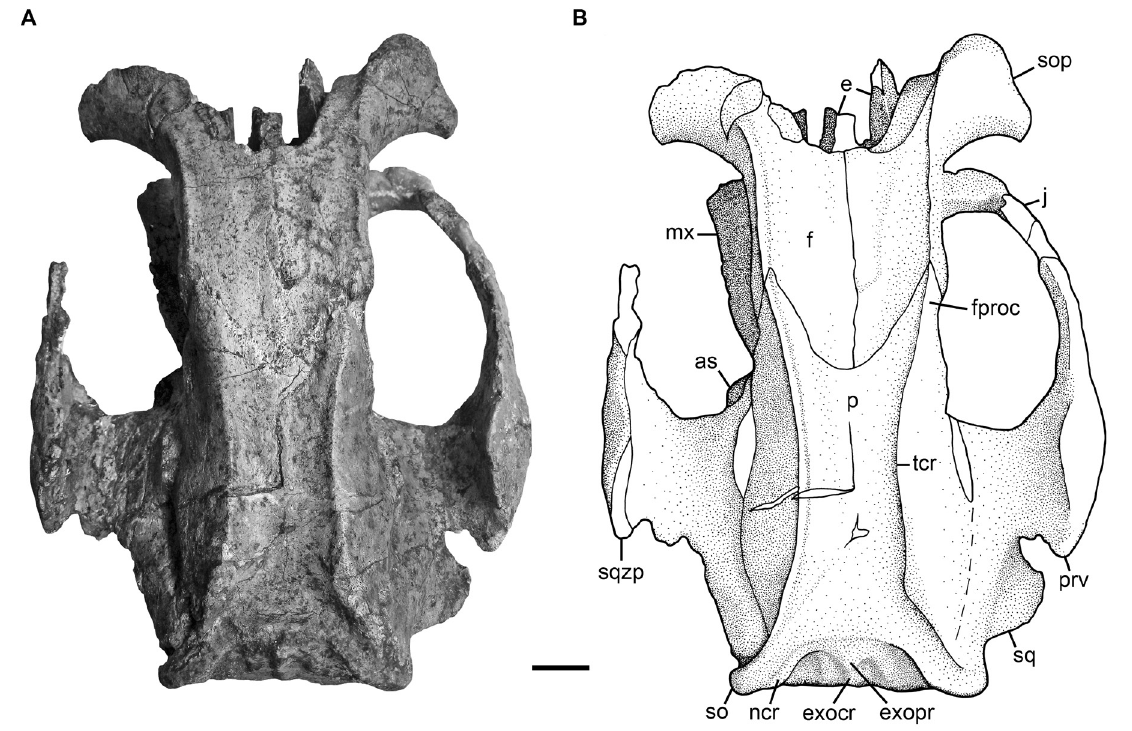
Fig. 2. Cranium of Lentiarenium cristolii ( Fitzinger, 1842) (OLL 1926/394) in dorsal view. A . Photograph. B . Drawing. White areas indicate either missing or reconstructed parts. Scale bar = 2